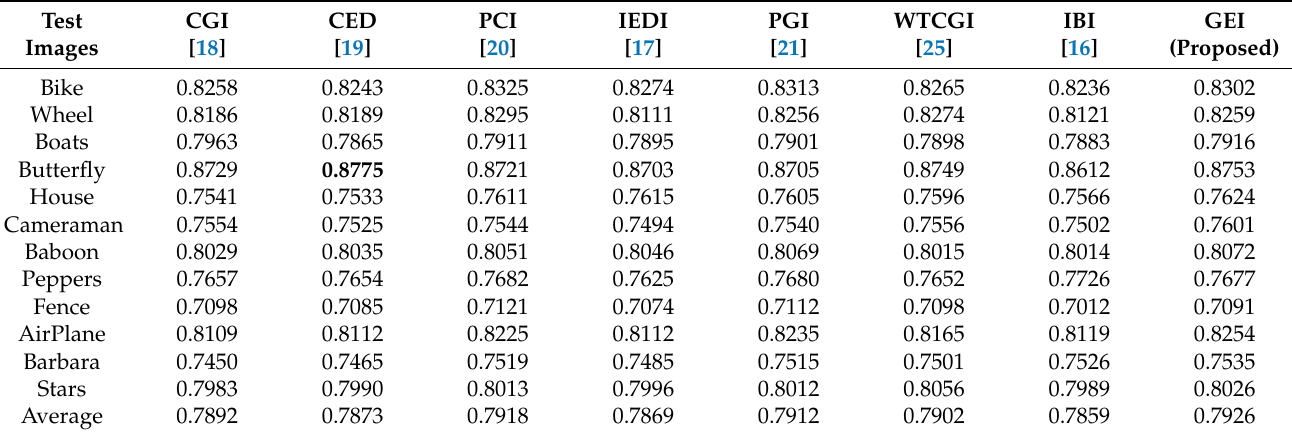
Table 4. A comparison of different interpolation methods with respect to the EPI